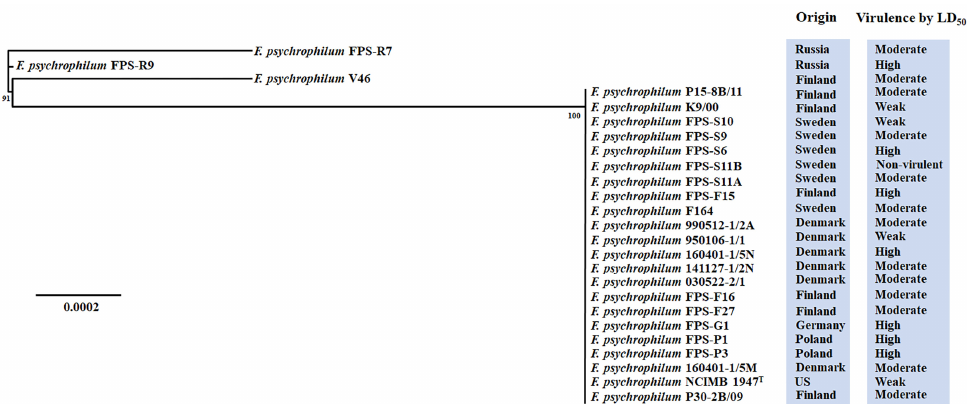
Figure 2. Core genome phylogeny of F. psychrophilum isolates . The maximum likelihood tree was obtained from a concatenated amino acid sequence alignment of the orthologous core genes (1866 ORFs) for the twenty-five F. psychrophilum isolates and the type strain NCIMB 1947 T . The numbers above the branches indicate the bootstrap value. Bootstrap values of <80% were removed from the tree. The horizontal bar at the base of the figure represents 0.01 substitution per amino acid site. The virulence properties of the isolates and geographical places of origin were added to facilitate com- parison.